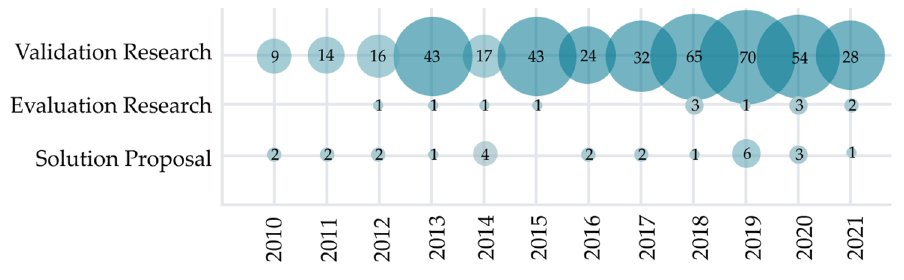
Figure 8. Number of studies by year and research methodology.